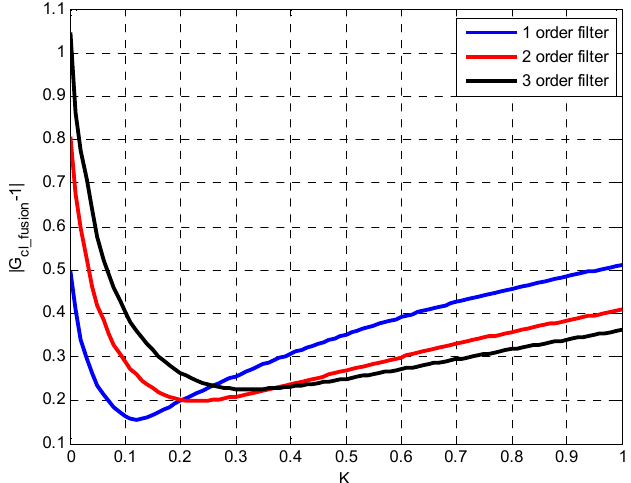
(cid:12) (cid:12) − 1 | when the filter order is | -1| G when the filter order is different. Figure 6. The fusion error of (cid:12) G cl _ fusion _ cl fusion